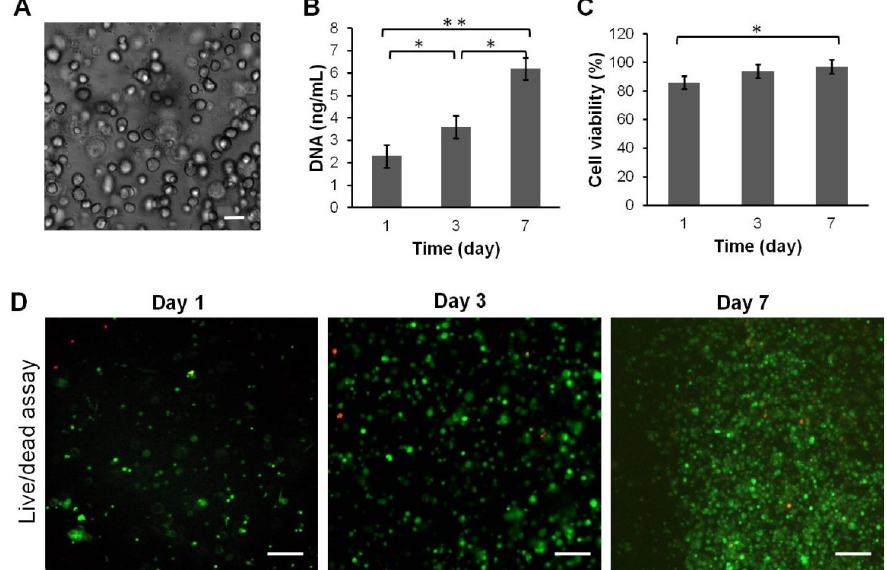
Figure 4. Cell viability and proliferation of rabbit SDMSCs encapsulated in HCF hydrogel. ( A ) Rep- resentative image of SDMSCs encapsulated in HCF hydrogel. Scale bar 20 μ m. ( B ) Proliferation of SDMSCs encapsulated in HCF hydrogel. ( C ) Cell viability percentage of SDMSCs from the total cell number (n = 3). ( D ) Fluorescent images of Live/Dead staining of SDMSCs encapsulated in HCF hy- drogel. Live cells (Green) and dead cells (Red). Scale bar 100 μ m. * p < 0.05, ** p < 0.01.